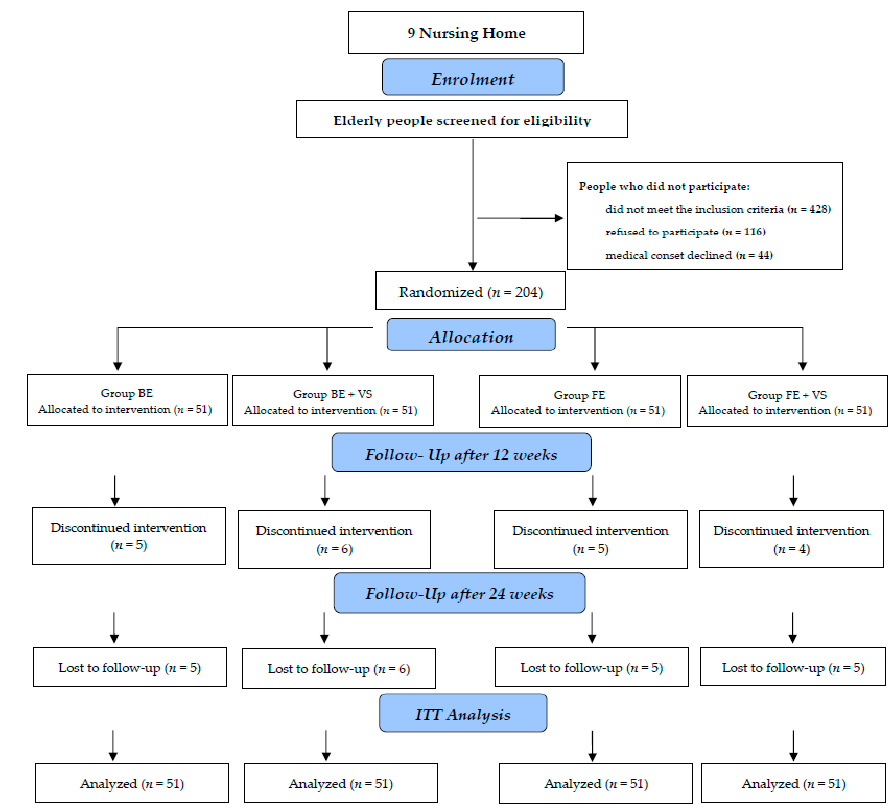
Figure 1. Flow diagram of the intervention study. ITT, intention-to-treat. Table 1. Sociodemographic and clinical characteristics of the